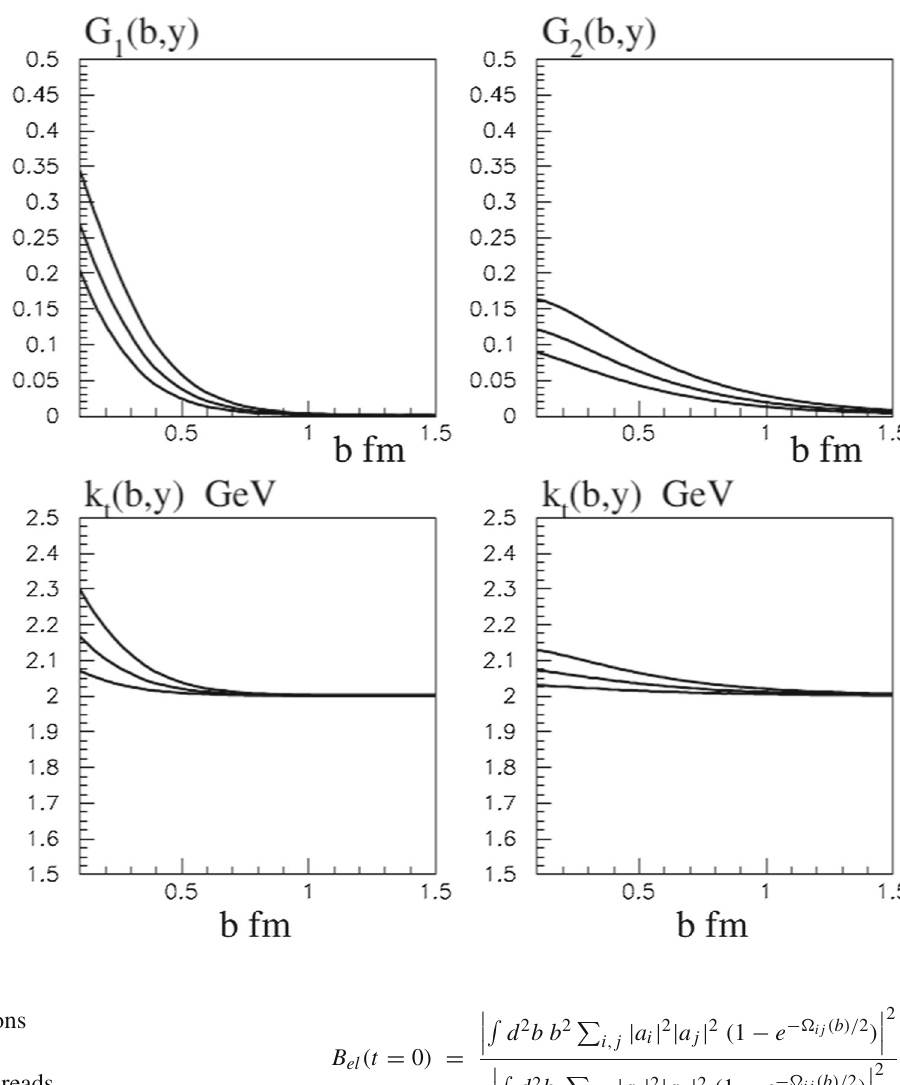
Fig. 3 Impact parameter, b , dependence of the parton densities, G i ( b , y ) (upper panels) and the characteristic transverse momenta, k ti ( b , y ) (lower panels) for the two G–W components, | φ 1 (cid:9) (left) and | φ 2 (cid:9) (right) at three values of rapidity y = 9, 6, 3 – the curves from top to bottom. We use the values of the parameters which have been tuned to describe the total and elastic p ¯ p and pp cross sections in the S p ¯ p S, Tevatron and the LHC colliders energy